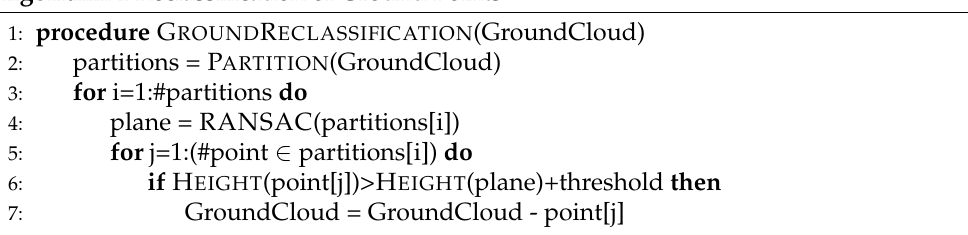
Algorithm 1 Reclassification of Ground